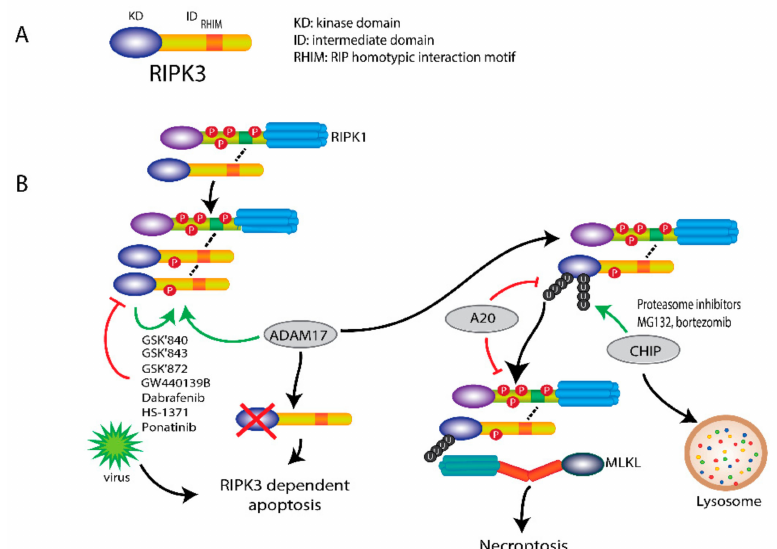
Figure 3. RIPK3-mediated necroptosis. ( A ) Scheme of RIPK3 structure. RIPK3 consists of an N-terminal kinase domain (KD), a RHIM containing intermediate domain (ID). ( B ) The association of RIPK1 with RIPK3 induces the phosphorylation and activation of RIPK3 by its kinase-activity and ADAM17. Upon inhibition of RIPK3 by specific inhibitors, such as GSK’840, GSK’843, GSK’872, GW440139B, HS-1371, ponatinib and dabrafenib (a B-raf inhibitor), RIPK3-dependent apoptosis is initiated, which can also be induced by viruses. Ubiquitination of RIPK3 also regulates RIPK3 activity. Upon necroptosis induction, RIPK3 is ubiquitinated at Lys5. Deubiquitination of RIPK3 Lys5 by A20 can inhibit necroptosis by blocking the interaction of RIPK1 and RIPK3 and the necrosome formation. In addition, ubiquitination of RIPK3 by CHIP at Lys55 and Lys363 can also block necroptosis by triggering lysosomal degradation. Proteasome inhibitors MG132 and bortezomib can induce necroptosis through the accumulation of polyubiquitination of RIPK3 at Lys264 without caspase-8